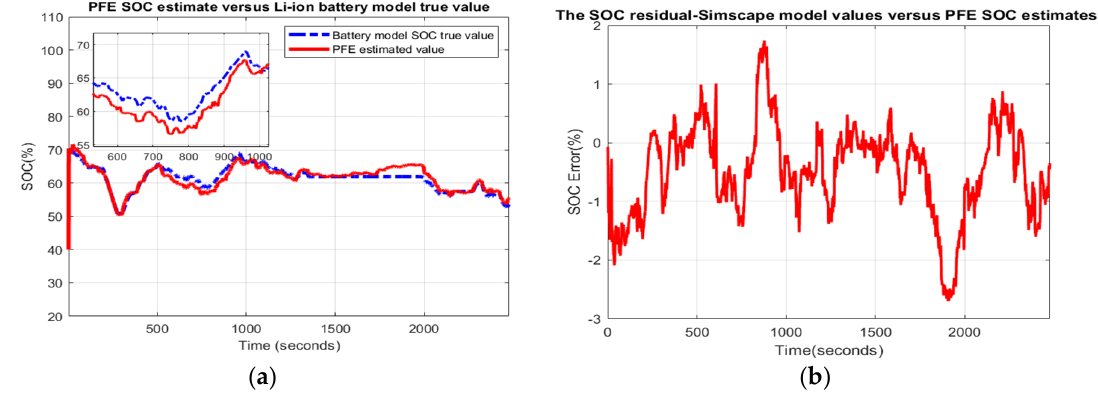
Figure A28. Robustness to changes in SOC initial value—SOCini = 0.4. ( a ) PFE SOC estimate versus battery SOC true value; ( b ) SOC residual.